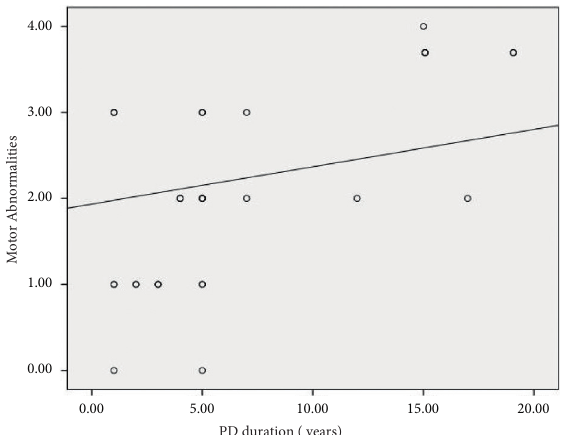
Figure 4: Scatter plot between motor abnormalities and PD duration.